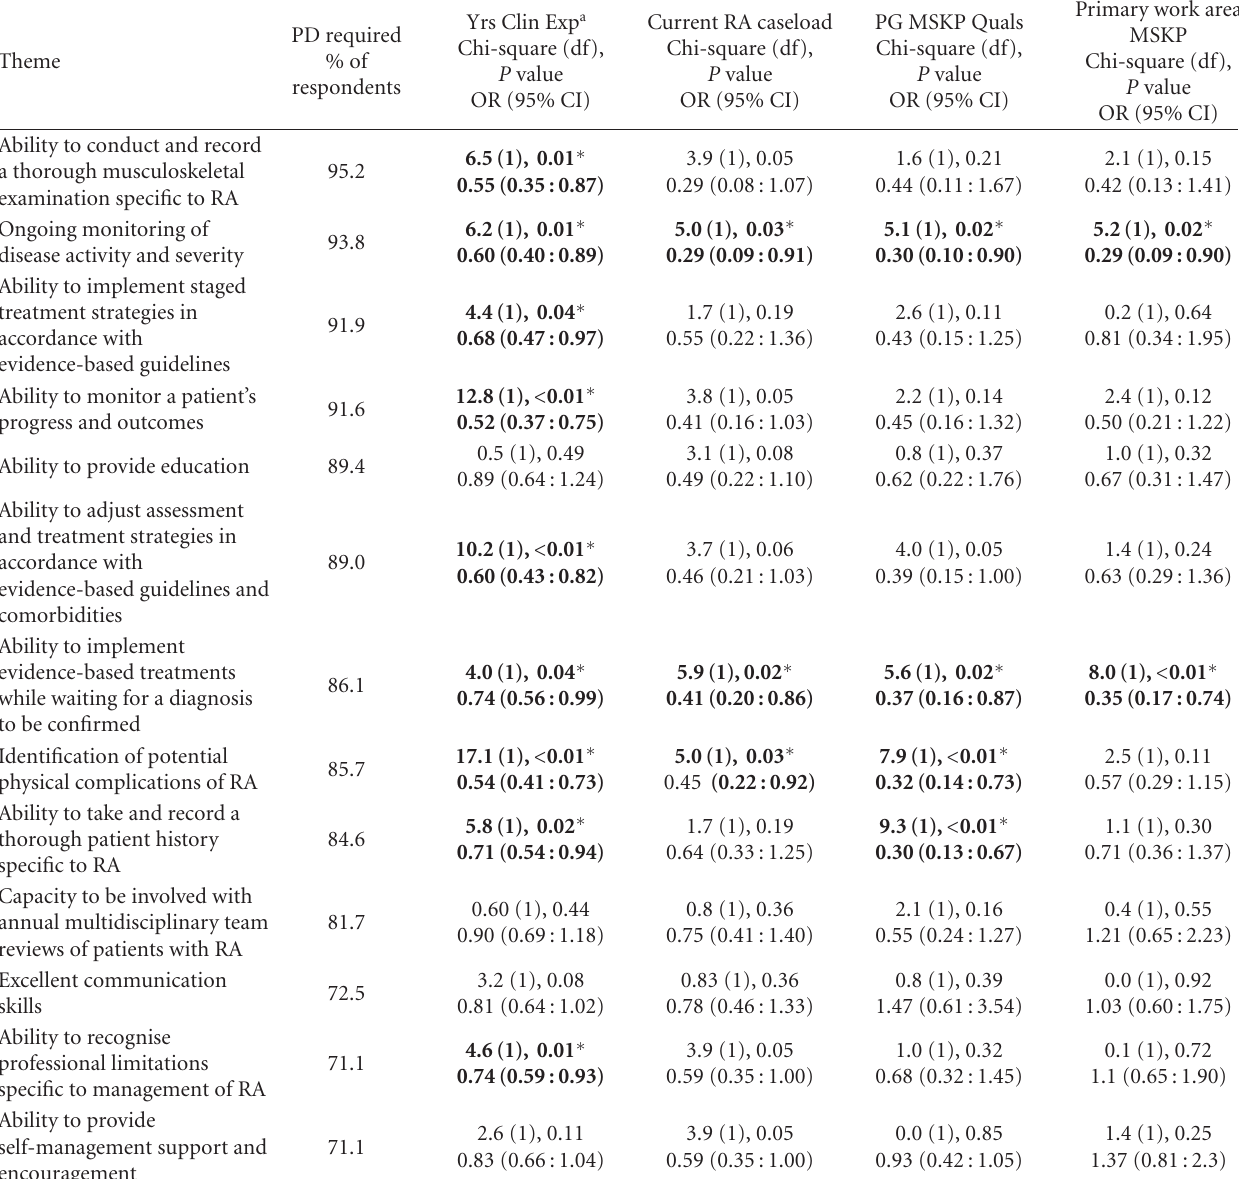
Table 4: Association between PD needs for skills items and the variables of years of clinical practice experience, current caseload of patients with RA, postgraduate (PG) qualifications in musculoskeletal physiotherapy (MSKP), and primary area of work in MSKP ( n =